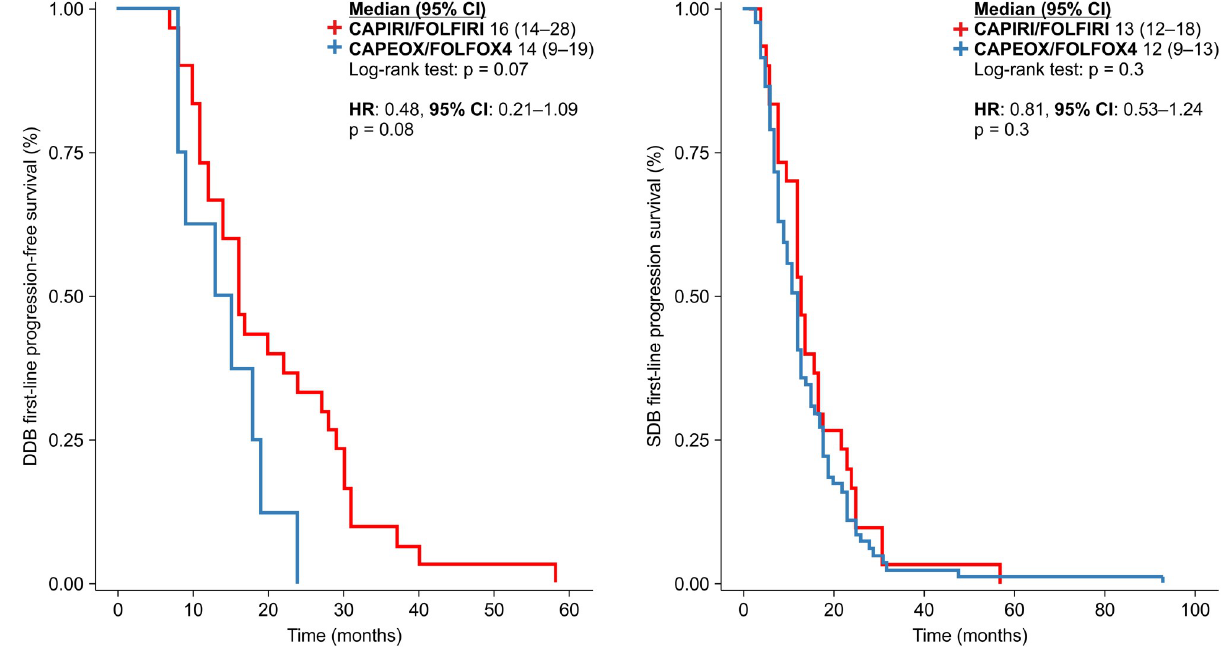
Fig 4. Progression-free survival in the first-line treatment of patients in the double-dose and standard-dose bevacizumab groups.